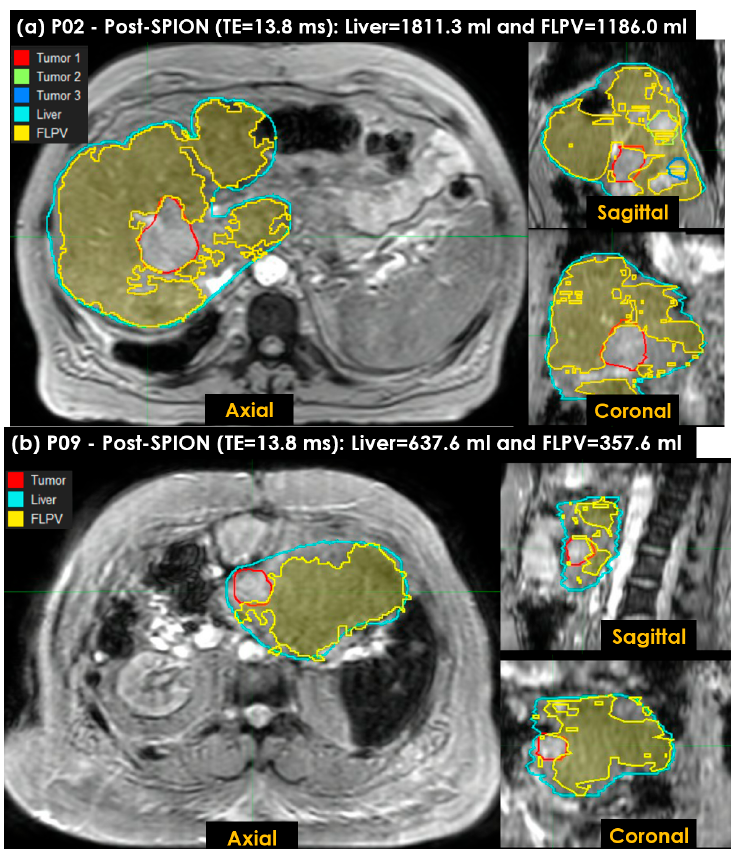
Figure 7. The functional liver parenchyma volume(s) FLPV(s), identified using the THRES-MEAN R2* of the first PRE-POST R2* approach in an auto-contouring in-house tool, were overlaid on liver images. ( a ) Three tumors in patient P02, contoured in red (first tumor), green (second tumor) and blue (third tumor), are illustrated to demonstrate the efficiency of the in-house tool for identifying the FLPV; ( b ) a single tumor in patient P09, contoured in red, is also illustrated. Both FLPVs of P02 and P09